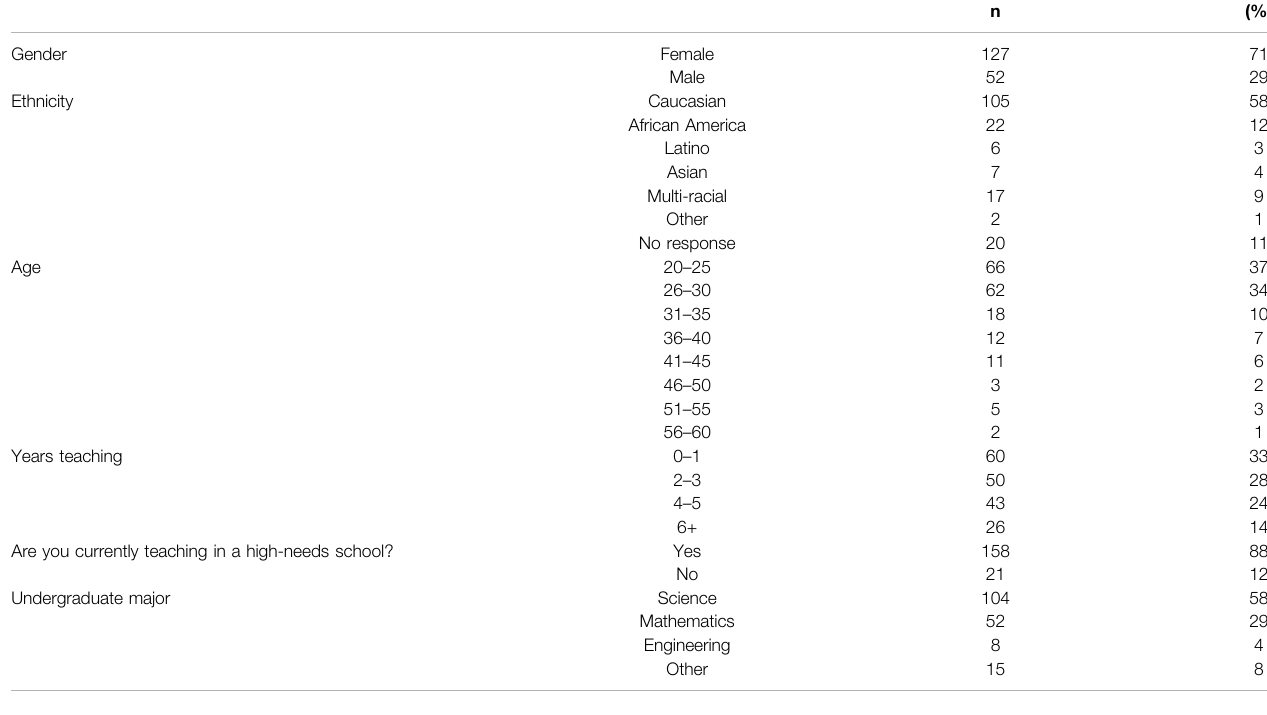
TABLE 1 | Survey participant demographics ( n (cid:1) 179).